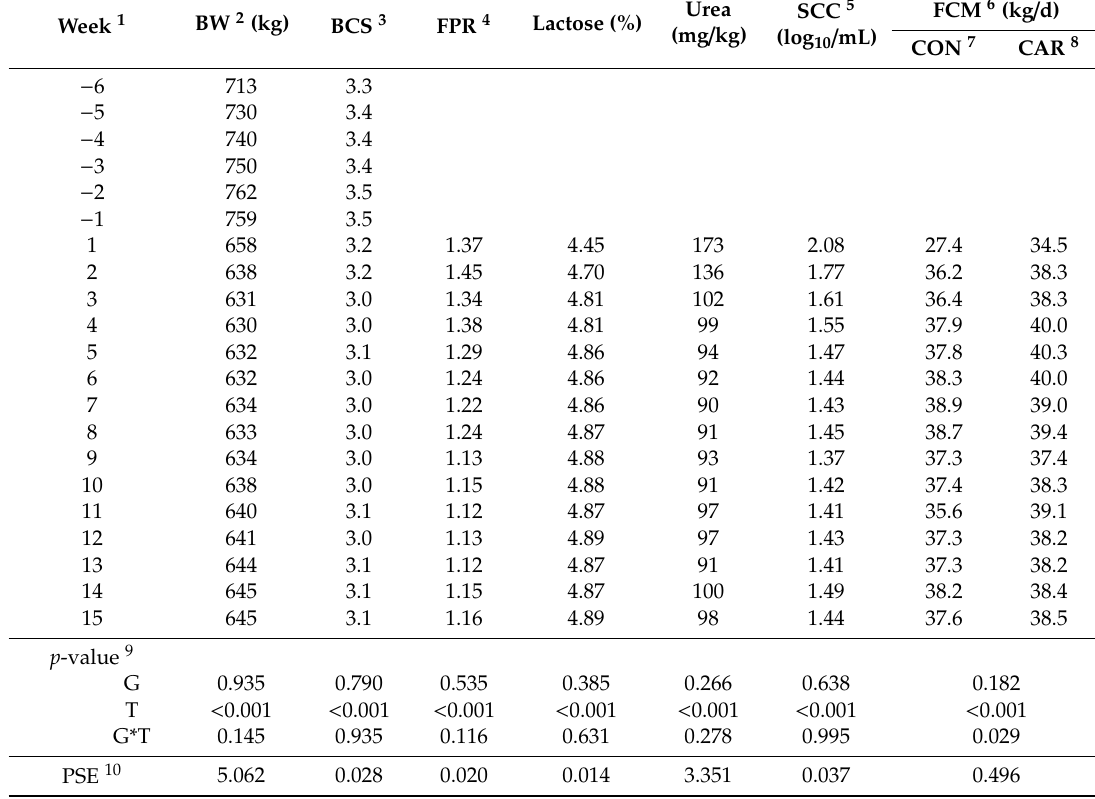
Table A3. E ff ects of an L-carnitine supplementation on body condition and milk